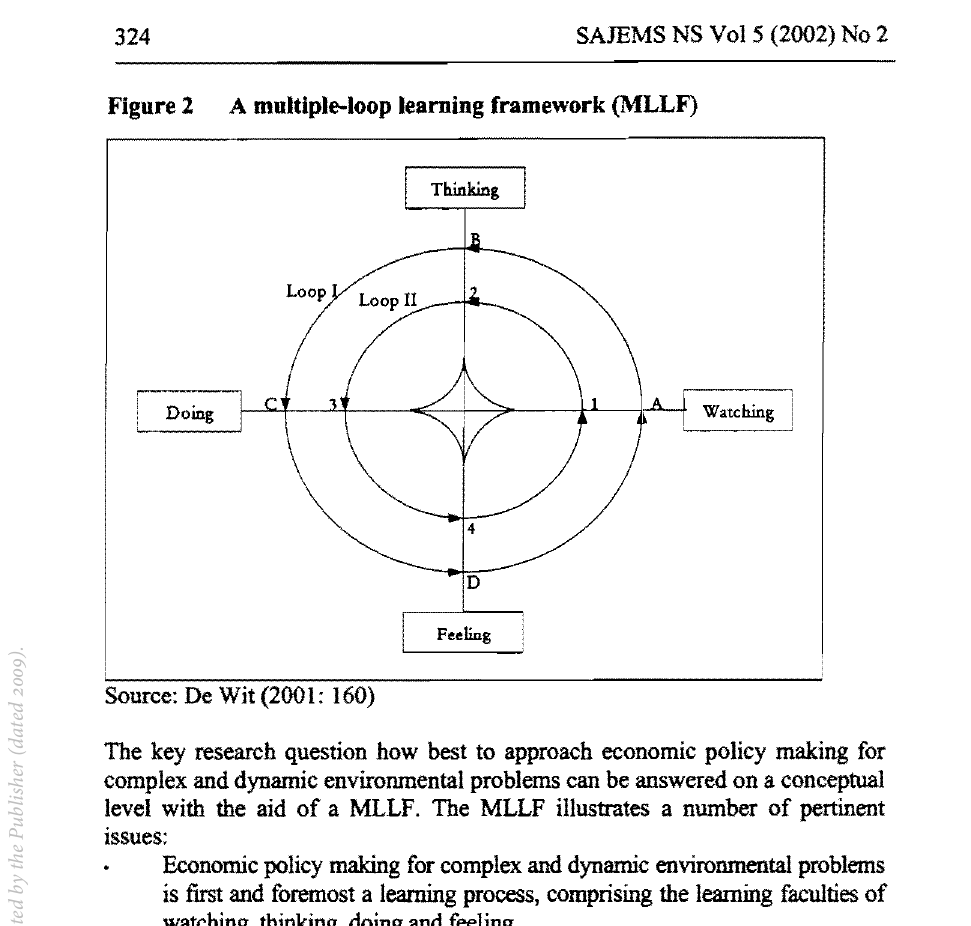
Figure 2 A multiple-loop learning framework